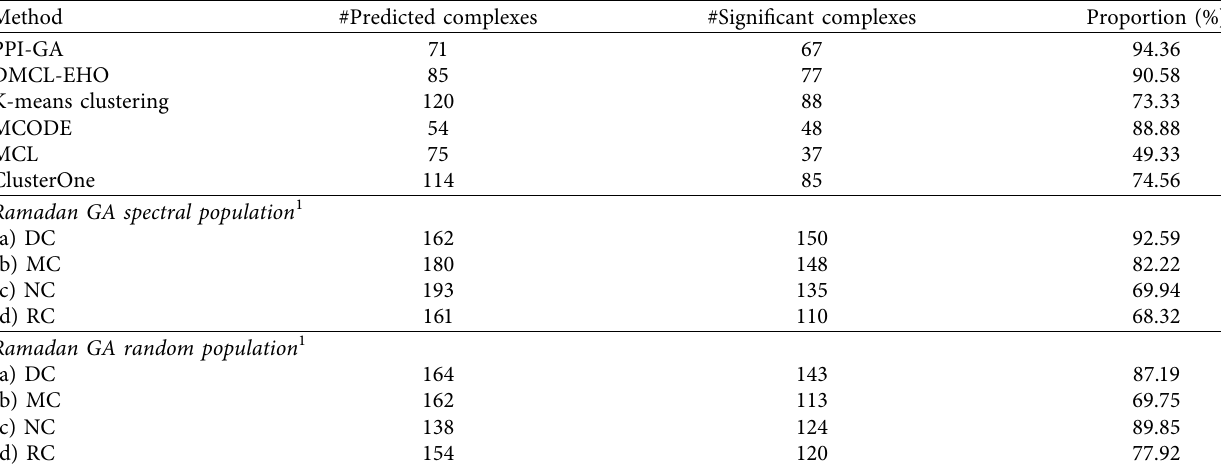
Table 14: Comparison of various algorithms in terms of significance of the predicted complexes for Collins data. Method